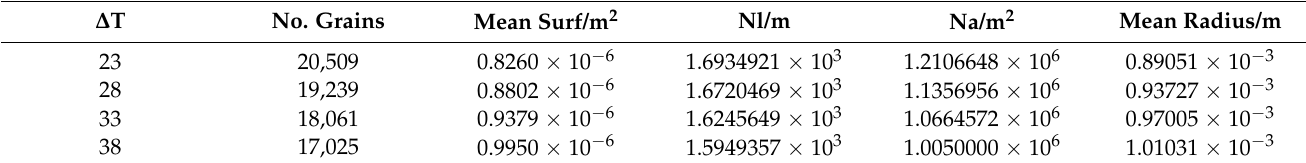
Figure 5. Simulated solidification structures under different superheats: ( a ) 23 K; ( b ) 28 K; ( c ) 33 K; ( d ) 38 K. (Different colors in figure represent grain orientation). Table 5. Statistical results of grain parameters and distribution in simulated area under different